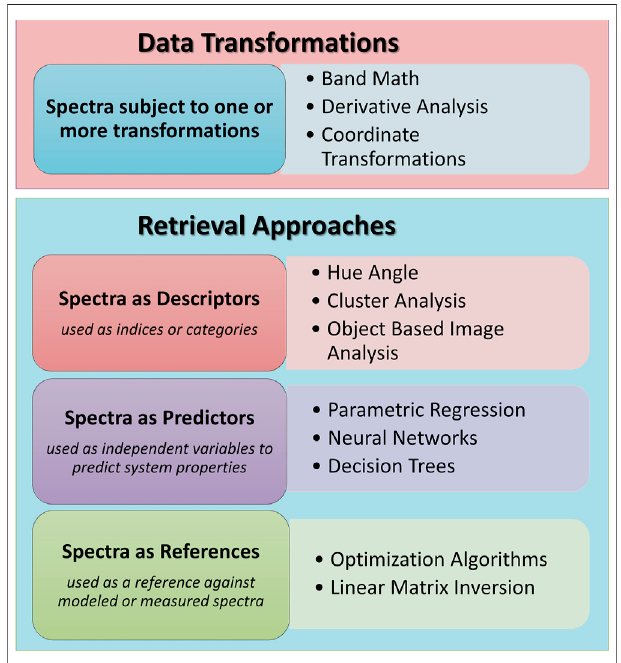
FIGURE 4 | Approaches for building a hyperspectral algorithm with selected